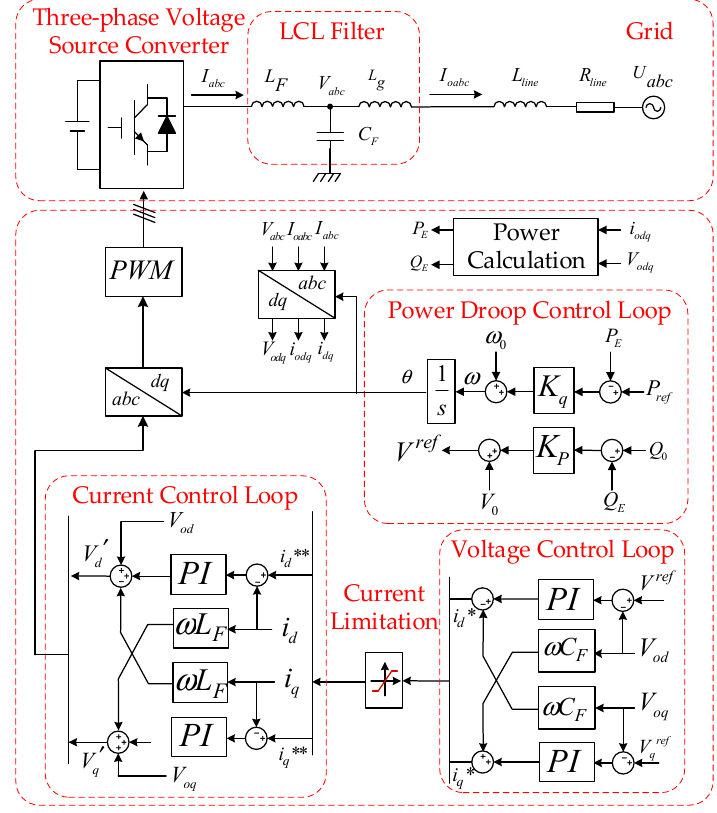
Figure 1. Three-phase voltage source converter based on droop control. The dq -axis voltage control loop in the middle layer is used to adjust the output voltage to follow the command value. It detects the deviation between the dq -axis voltage feedback and the command value, adjusts the output current command through the PI controller, drives the voltage feedback to follow the voltage command, prevents overcurrent, and often limits the amplitude.